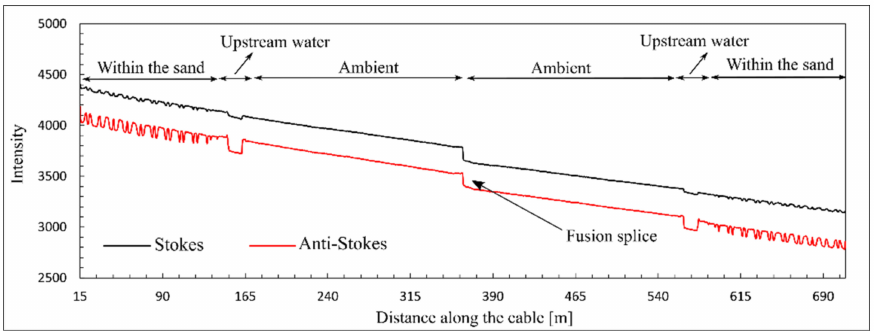
Figure 6. Stokes and anti-Stokes scattering at